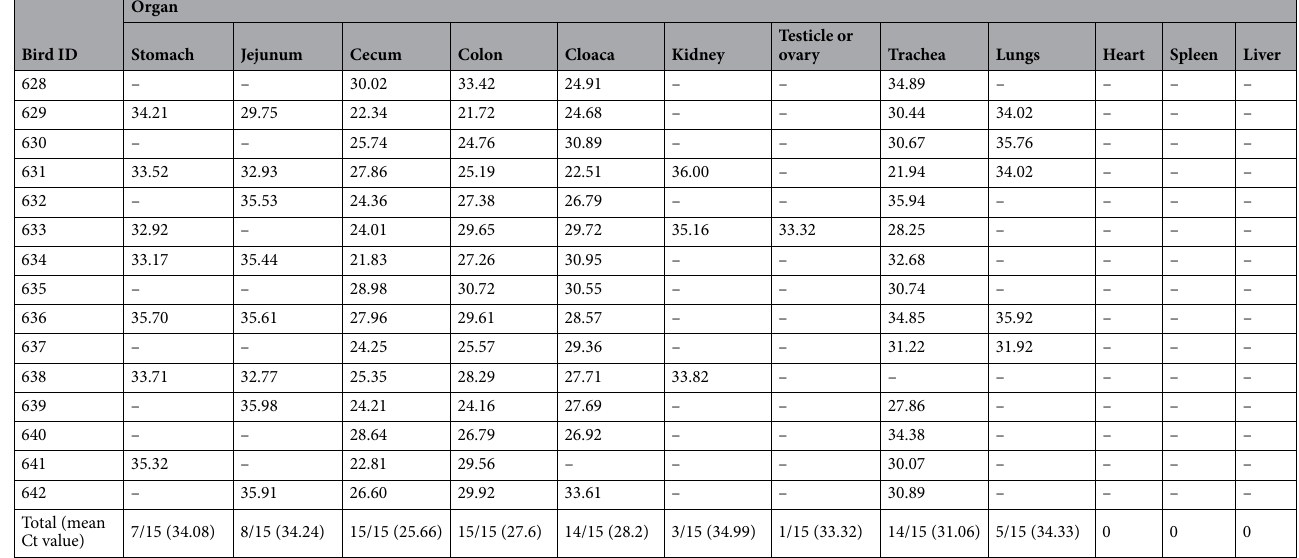
Table 2. Ct values obtained for the detection of C. gallinacea DNA in organs of inoculated broilers.